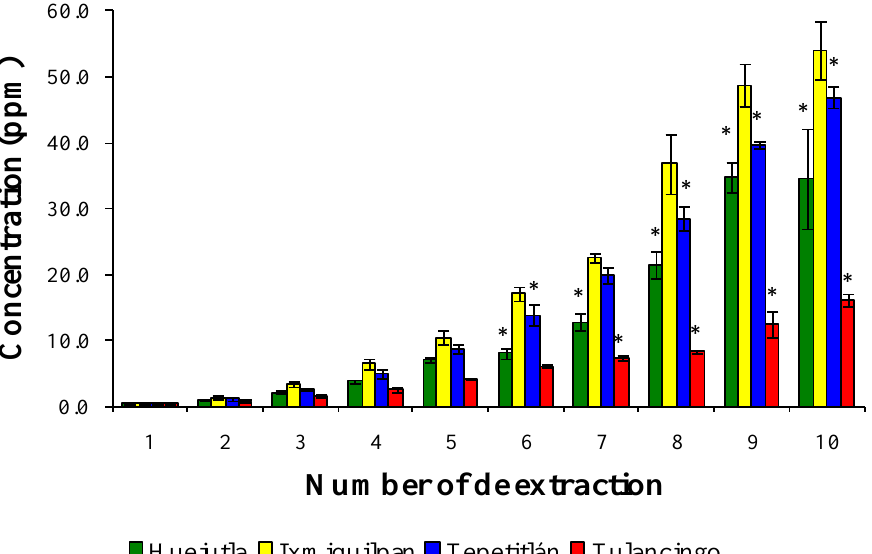
Figure 1. Concentration of Cd leached from the glass-clay containers into the green tomato sauce (salsa). The bars show the mean values of the four regions studied with their standard deviations. * Indicates significant statistical differences with respect to the Ixmiquilpan region, which represents the highest concentration of the metal; p ≤ 0.05.